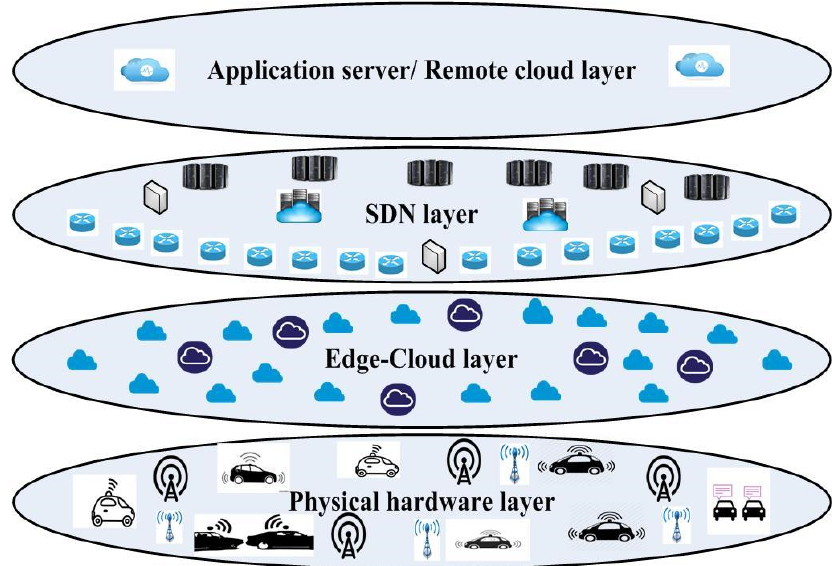
Figure 2. Layer system of the proposed multilevel VANET system.